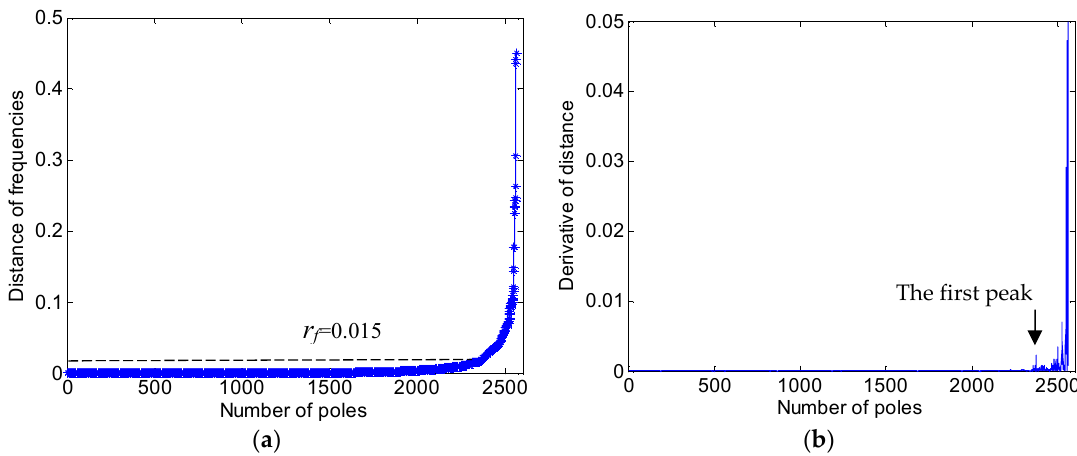
r : ( a ) the vector SS ; and ( b ) the first peak of the derivative of f 15